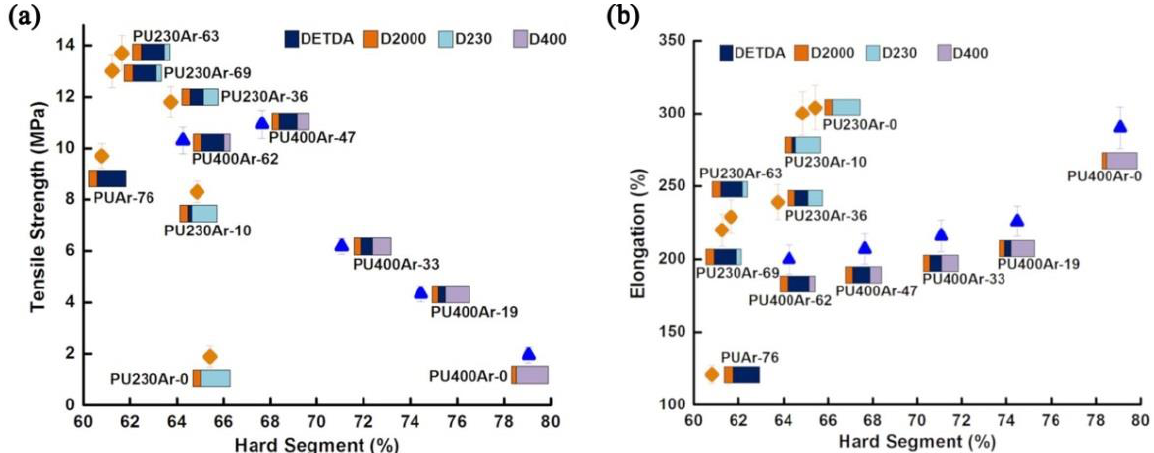
Figure 3. Influence of replacing DETDA with aliphatic chain extender on tensile strength ( a ) and elongation ( b ). The percent contribution of aromatic and aliphatic chain extender is also incorporated in the figure. Reproduced with permission from ref. [4].